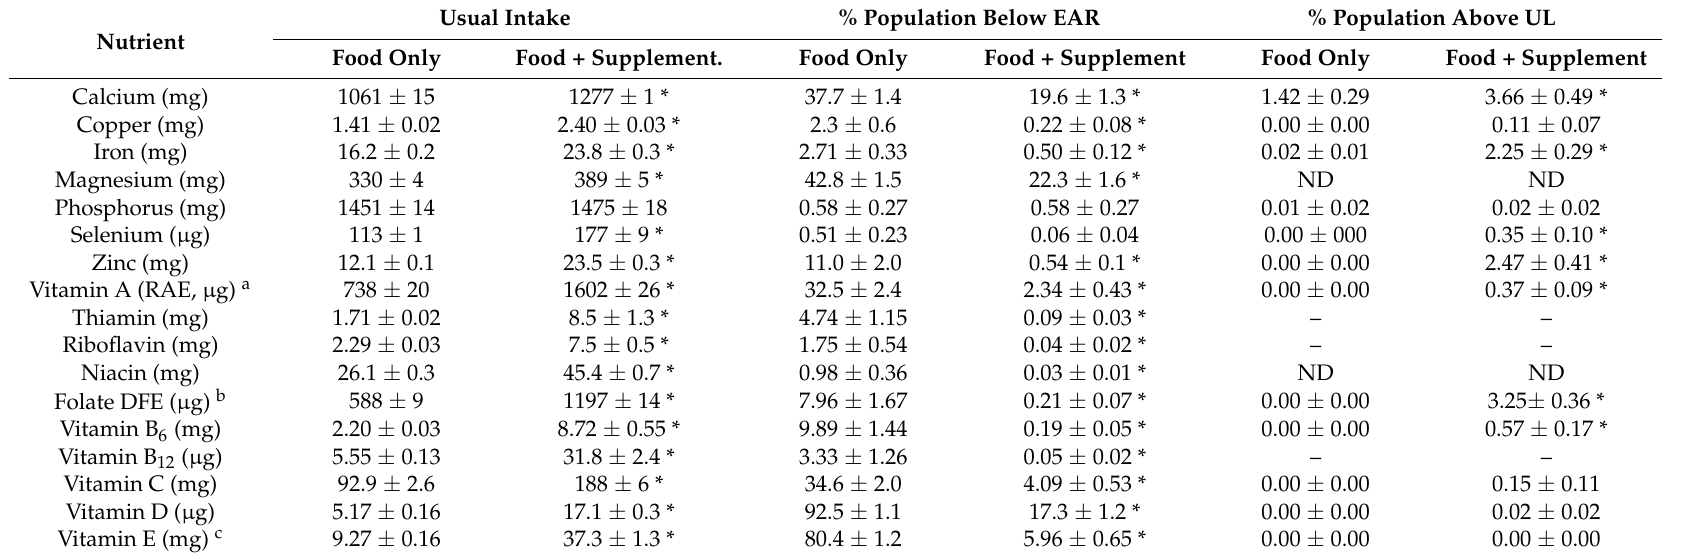
Table 1. Usual intake, prevalence of inadequacy (% of population below EAR) and % of population exceeding the UL of 17 micronutrients from food only and food + MVMS among adults age 19 years and older reporting taking a MVMS. NHANES